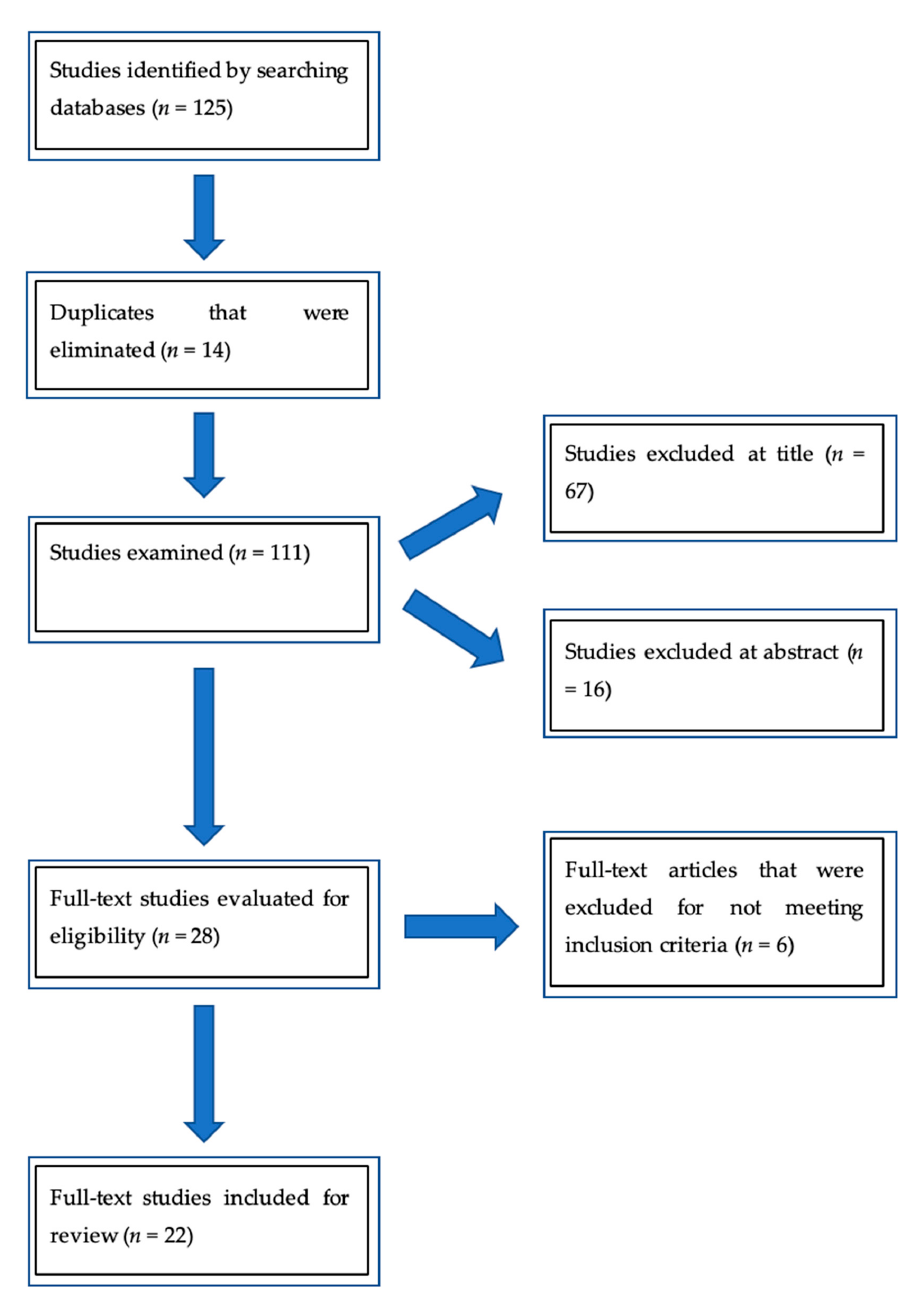
Figure 1. The flow diagram of the process for study selection.